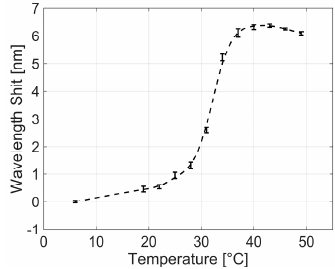
Figure 7. Resonant wavelength shift as function of solution temperature at pH 4 for the optrode fabricated with the new optimized procedure. The error bars represent one standard deviation evaluated on 5 acquisitions. The dashed lines were obtained with a smoothing spline fitting.